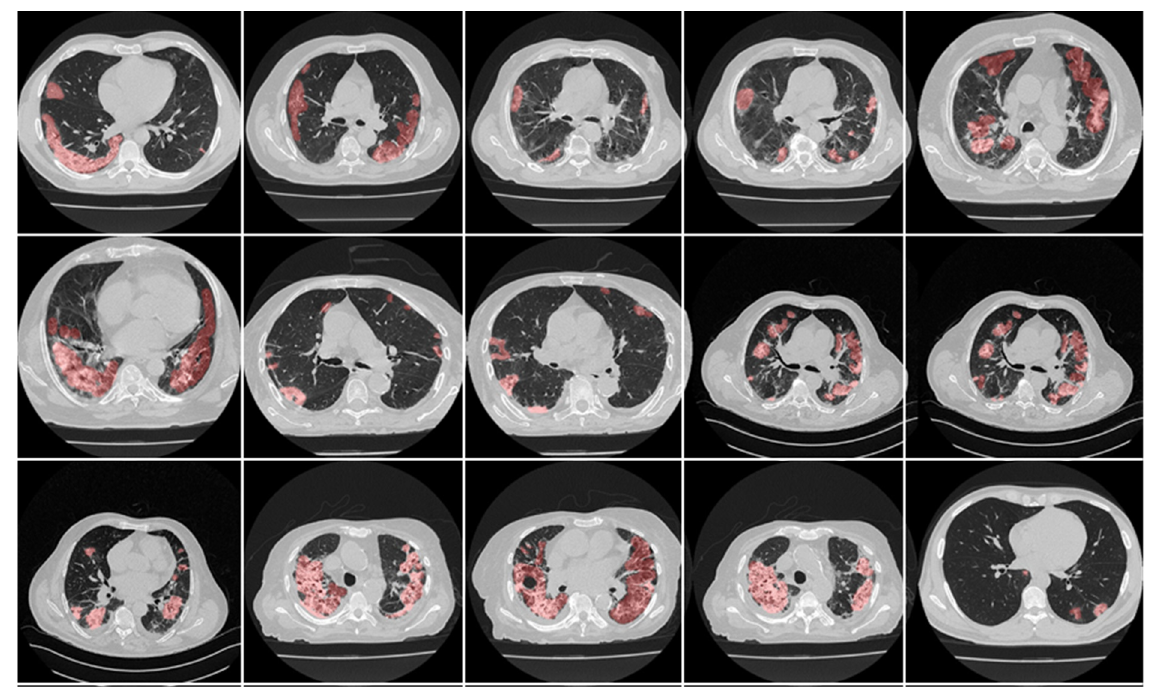
Figure 4. Manual delineation overlays (red) from tracer 2 on raw CT images.